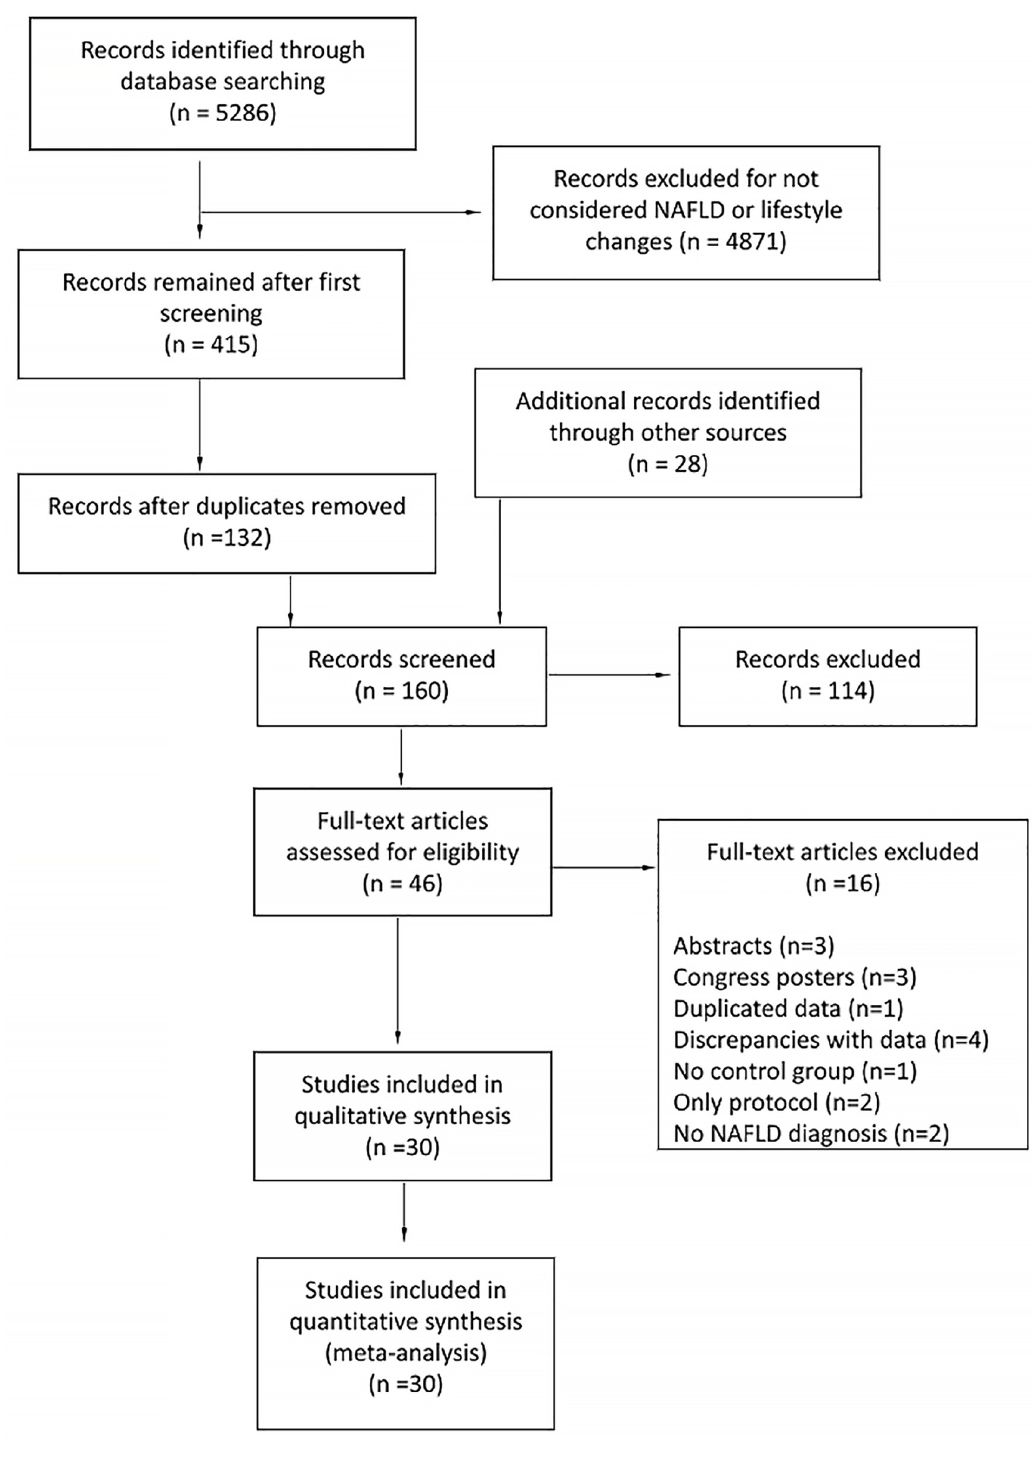
Fig 1. Flowchart of studies selection process.